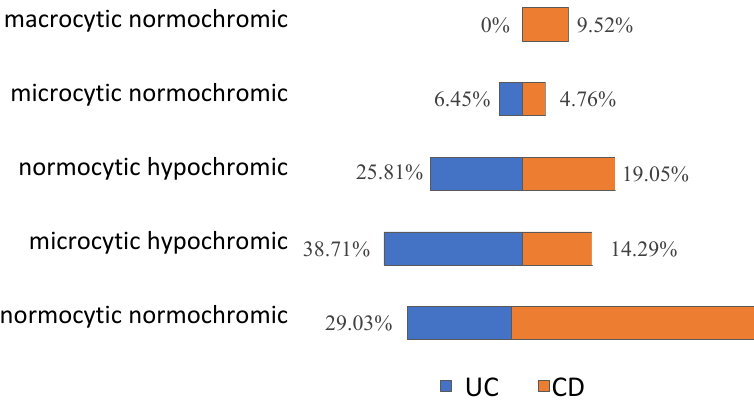
Figure 1. Severity of anaemia in patients with ulcerative colitis (UC) and Crohn’s disease (CD).